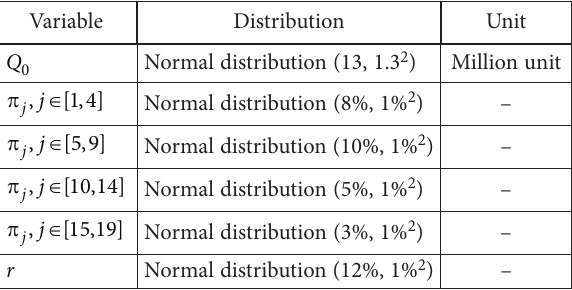
Table 1. Probability distributions of stochastic input variables